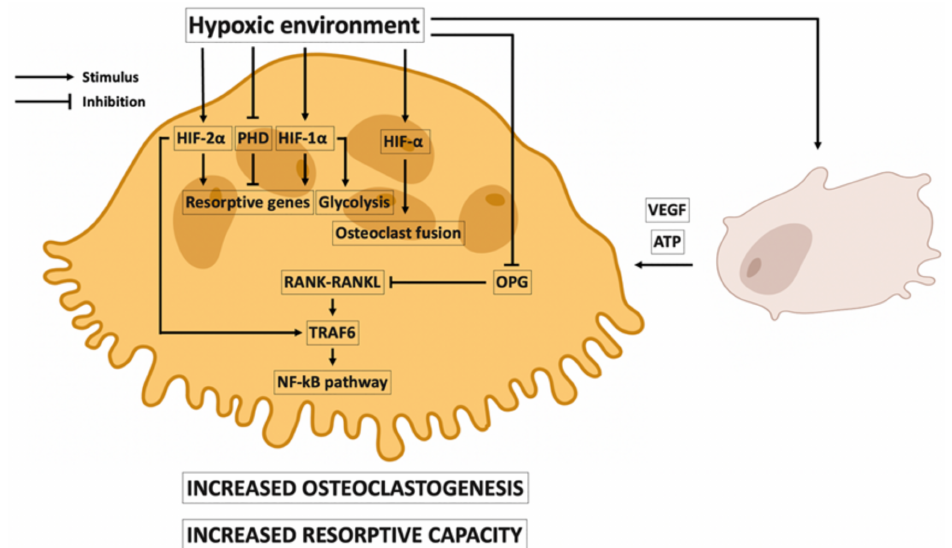
Figure 3. Effects of hypoxia on osteoclasts. Under hypoxic conditions osteoclastogenesis is increased. Hypoxia-inducible factors 1 α and 2 α (HIF-1 α and HIF-2 α ) activate osteoclast fusion. HIF-2 α is also involved in the expression of TRAF6, increasing NF- κ B pathway activation and osteoclast maturation. NF- κ B is also activated because hypoxia decreases osteoprotegerin (OPG) expression. Hypoxia is associated with increased osteoclast resorptive capacity. Pro-resorptive gene expression is activated by HIF-1 α and HIF-2 α and by the inhibition of the prolyl hydroxylase domain (PHD). HIF-1 α is also involved in the stimulation of glycolytic activity. In the osteoclast response to hypoxia, osteoblast– osteoclast crosstalk is crucial. Resorptive osteoclast activity is stimulated by vascular endothelial growth factor (VEGF) and adenosine triphosphate (ATP); VEGF and ATP are released by osteoblasts in a hypoxic